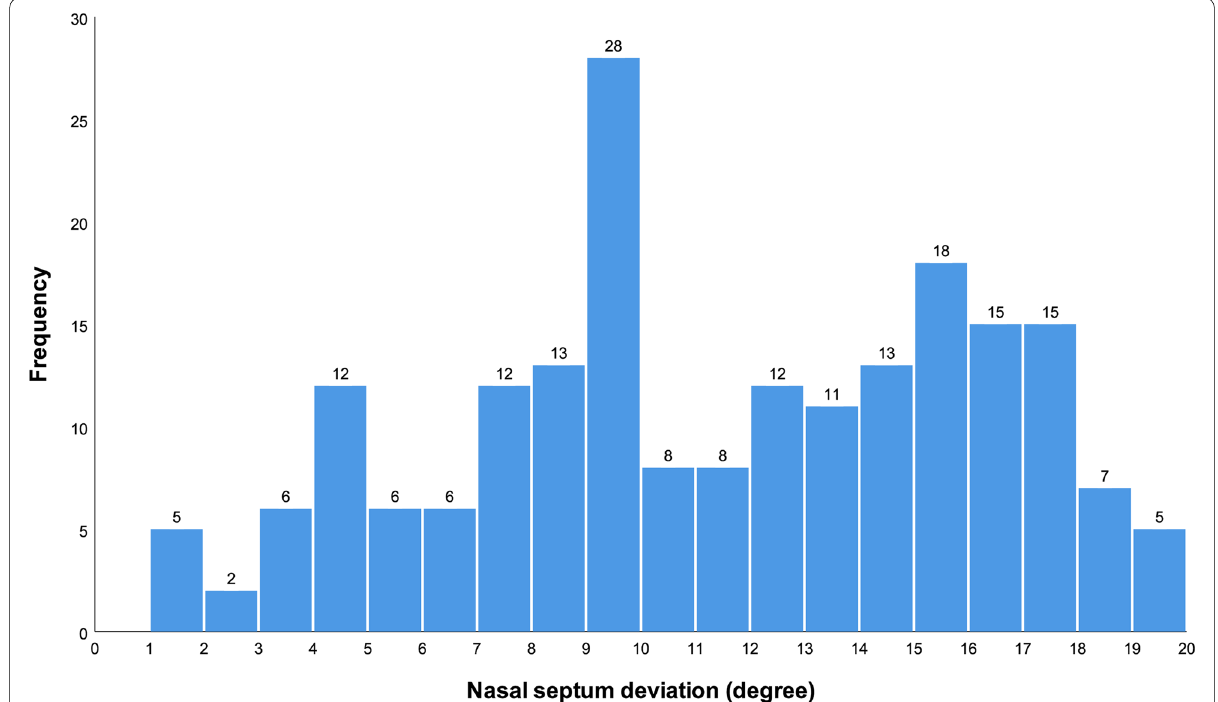
Fig. 3 A histogram showing the frequency of different NSD extents